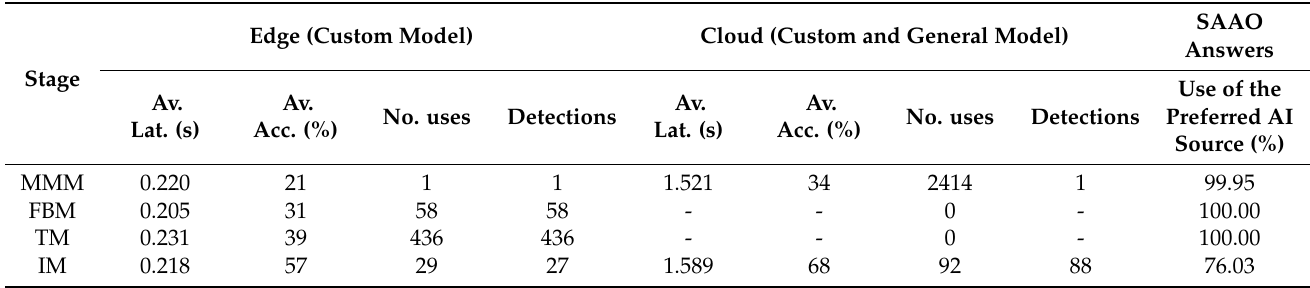
Table 5. Summary of SAAO logs during the